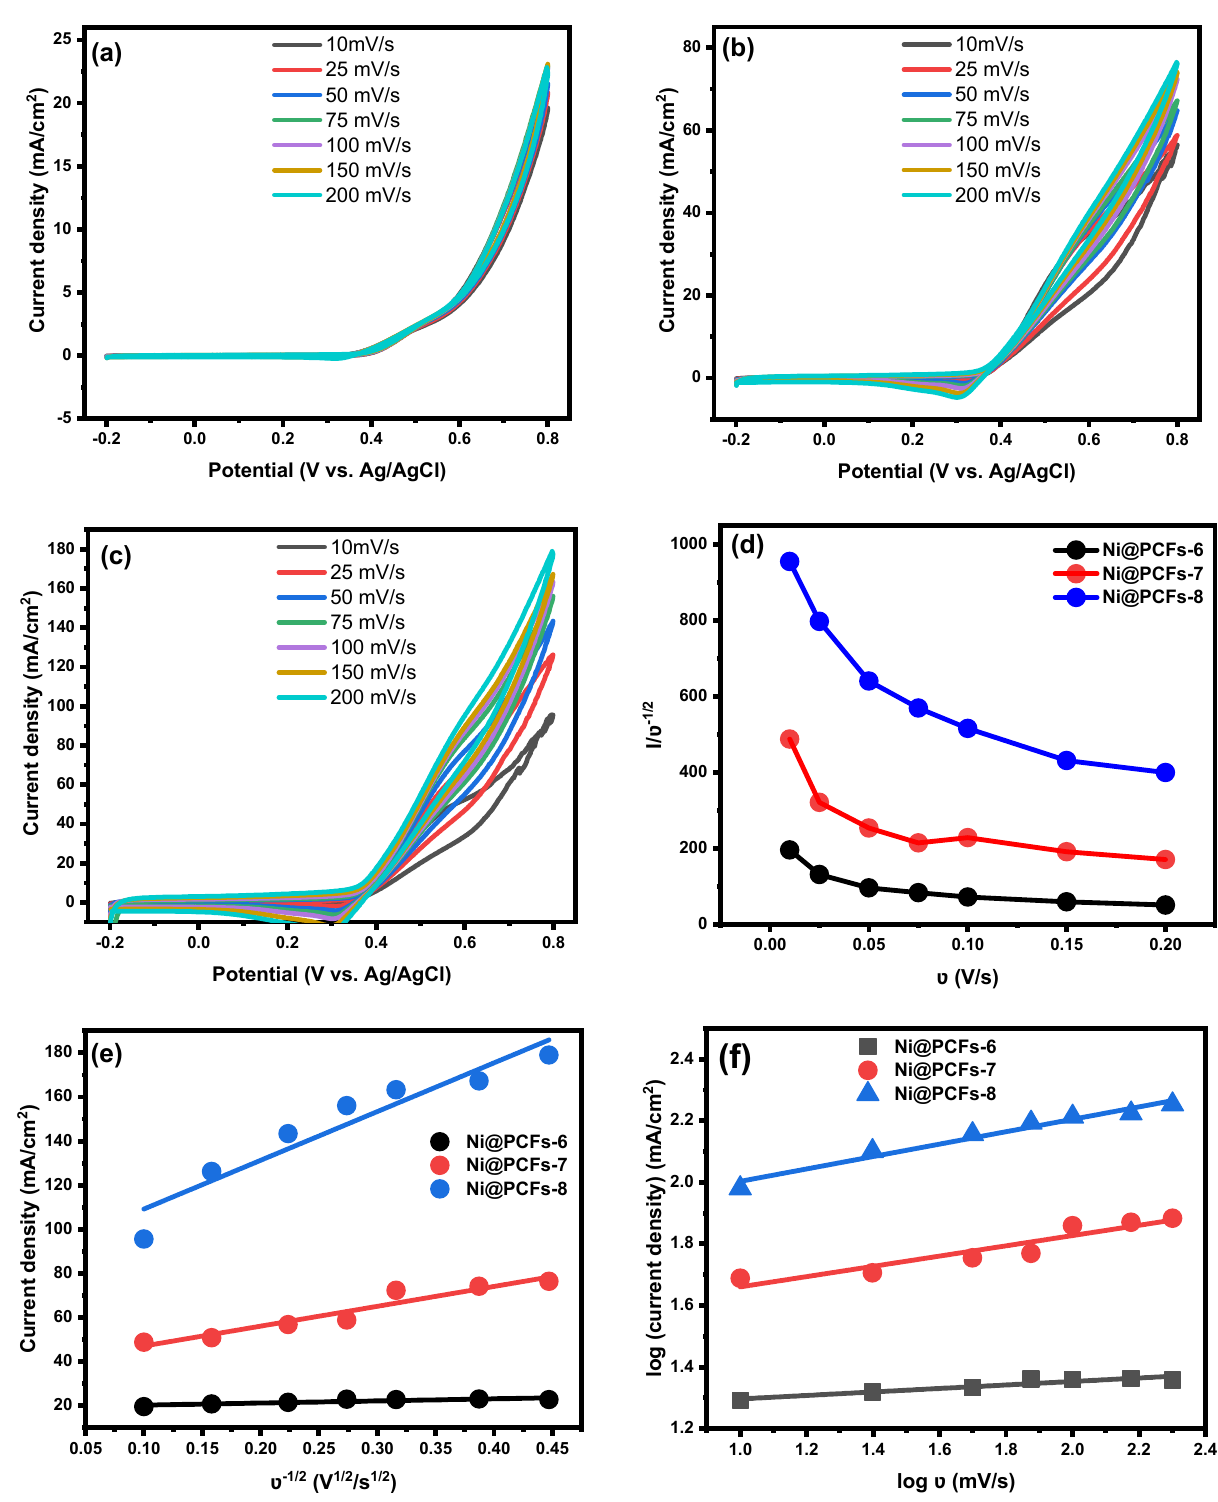
Figure 7. Effect of the scan rate on the electrooxidation of methanol in 1.0 M of KOH at the ( a ) Ni@PCFs-6, ( b ) Ni@PCFs-7, ( c ) Ni@PCFs-8. ( d ) The plot of methanol oxidation peak current density/ ν 1/2 values as a function of the ν . ( e ) The plot of methanol oxidation peak current density values as a function of the ν 1/2 . ( f ) The plot of the logarithm of methanol oxidation peak current density values as a function of the logarithm of ν 1/2